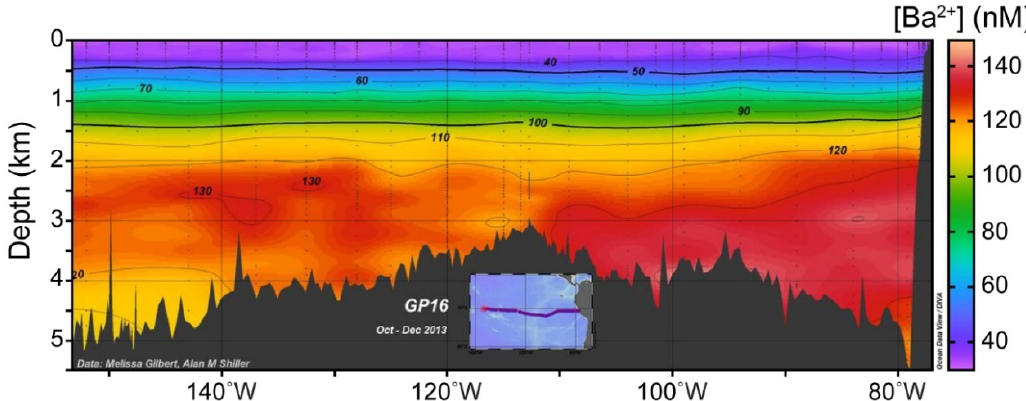
Figure 3. The distribution of dissolved barium (Ba 2 + ) along a transect in the eastern tropical Pacific Ocean (along latitude of 10°–15°S). The data were collected as part of GEOTRACES cruise GP16 [51] (figure produced using egeotraces.org [52]).